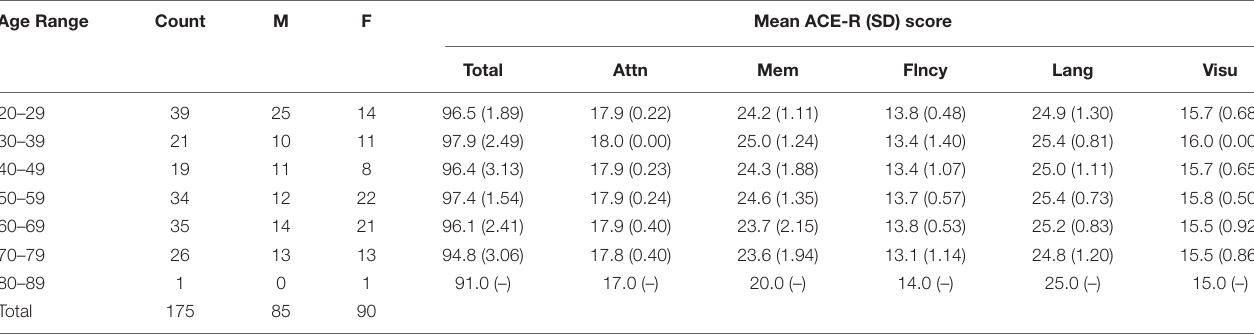
TABLE 1 | Participants’